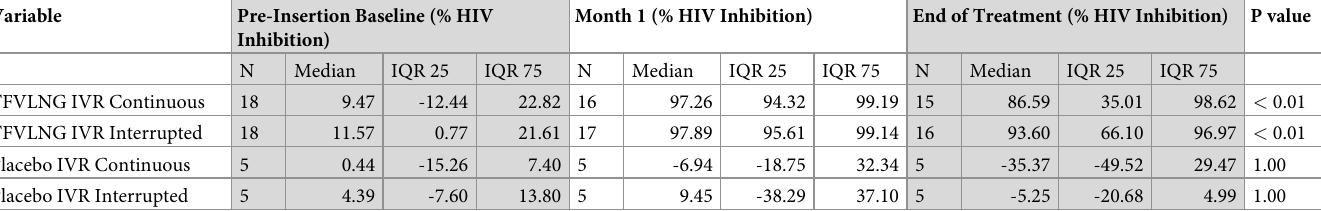
Table 5. In vitro HIV inhibitory activity of the CVL supernatant for each treatment and dosing regimen.